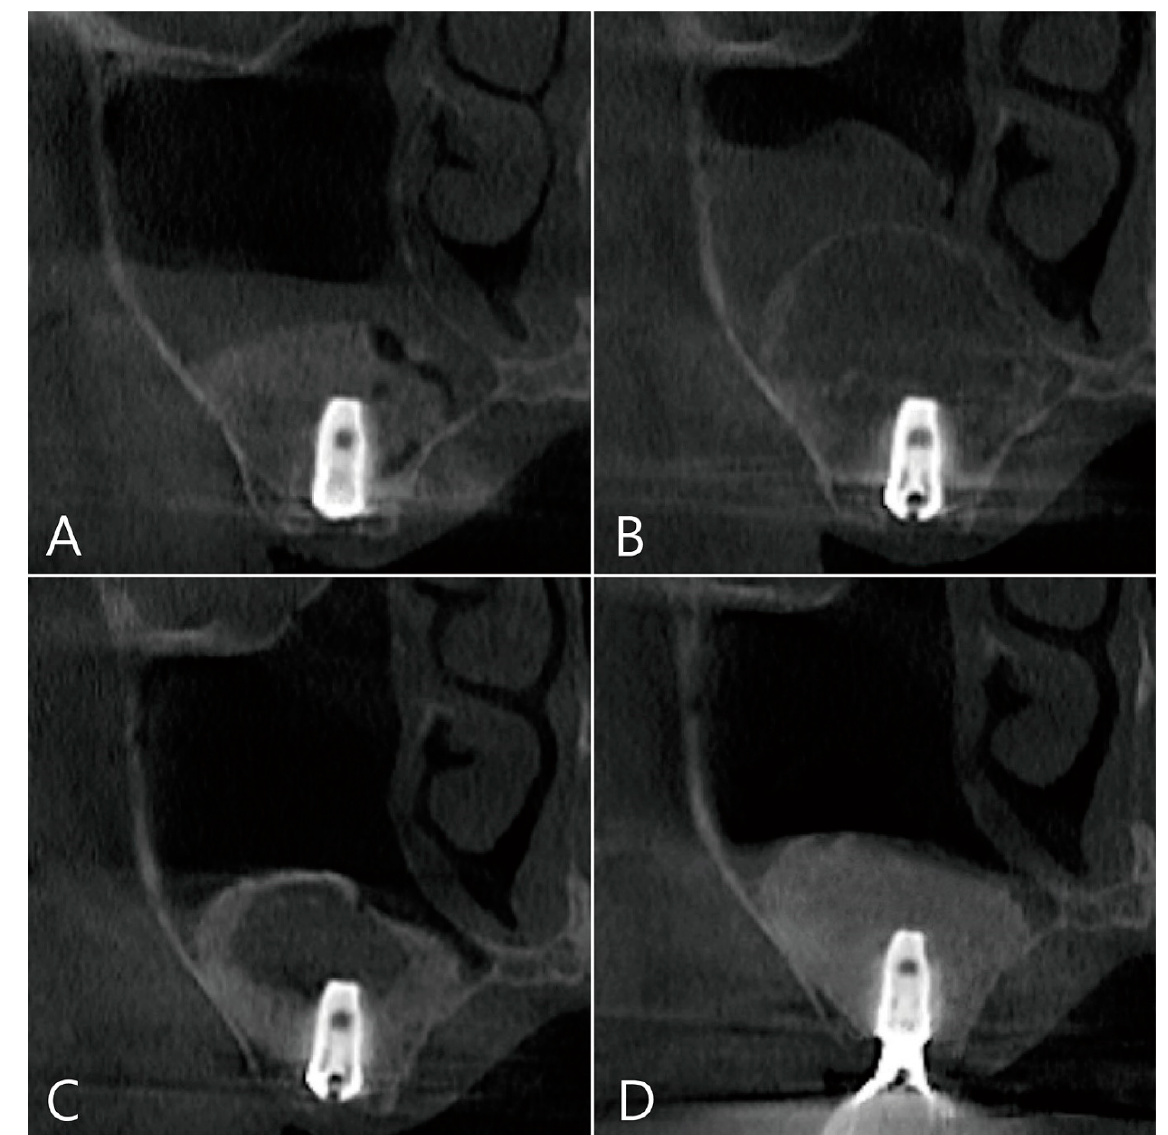
Figure 7. Coronal images of the CBCT were taken at multiple points during the healing process after surgery: ( A ) an image taken immediately after surgery; ( B ) an image taken one week after surgery. A large grafting void occurred over the apical half of the implant, and thickening of the maxillary sinus mucosa was also observed; ( C ) in the image 6 months after surgery, the size of the grafting void was slightly reduced. The void presents with a cystic appearance resembling SCC. The apical bony support of the implant was lost. The grafting void was removed and additional bone grafting was performed; ( D ) in the CBCT image taken 6 months after the prosthesis was delivered, it can be confirmed that the previous grafting void was replaced with a bone graft substitute.